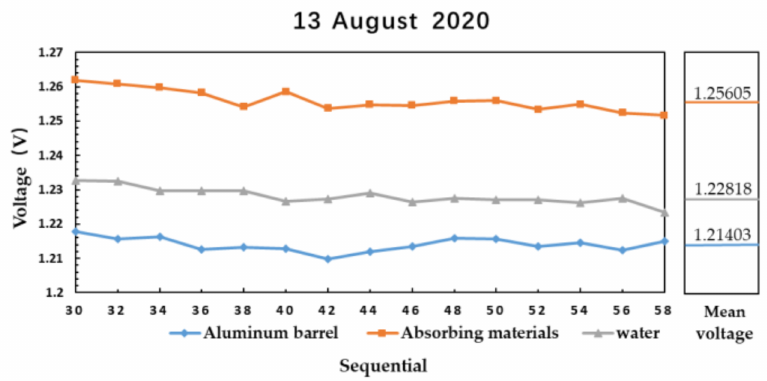
Figure 14. The result of microwave radiometer measuring aluminum plate, absorbing material, and water sealed in aluminum barrel on 13 August 2020.